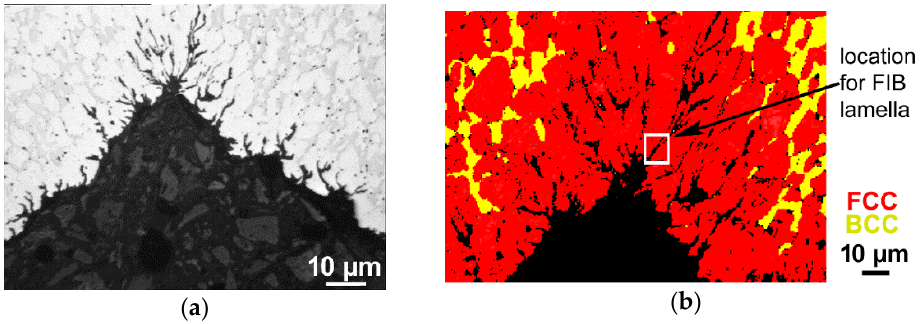
Figure 4. OM image of the cracked area ( a ); SEM-EBSD scan of the cracked area, with a map of phase composition ( b ).